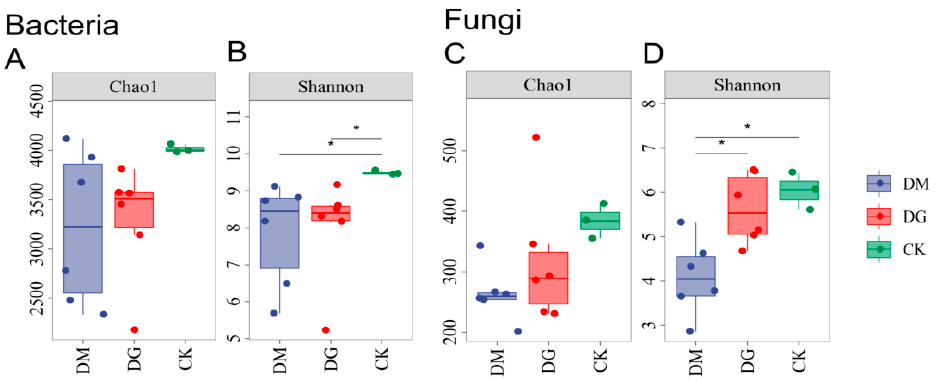
Figure 1. For bacterial ( A , B ) and fungal ( C , D ) communities, Chao1 and Shannon indices. The symbol * above the bar indicates significant differences between samples ( p < 0.05).